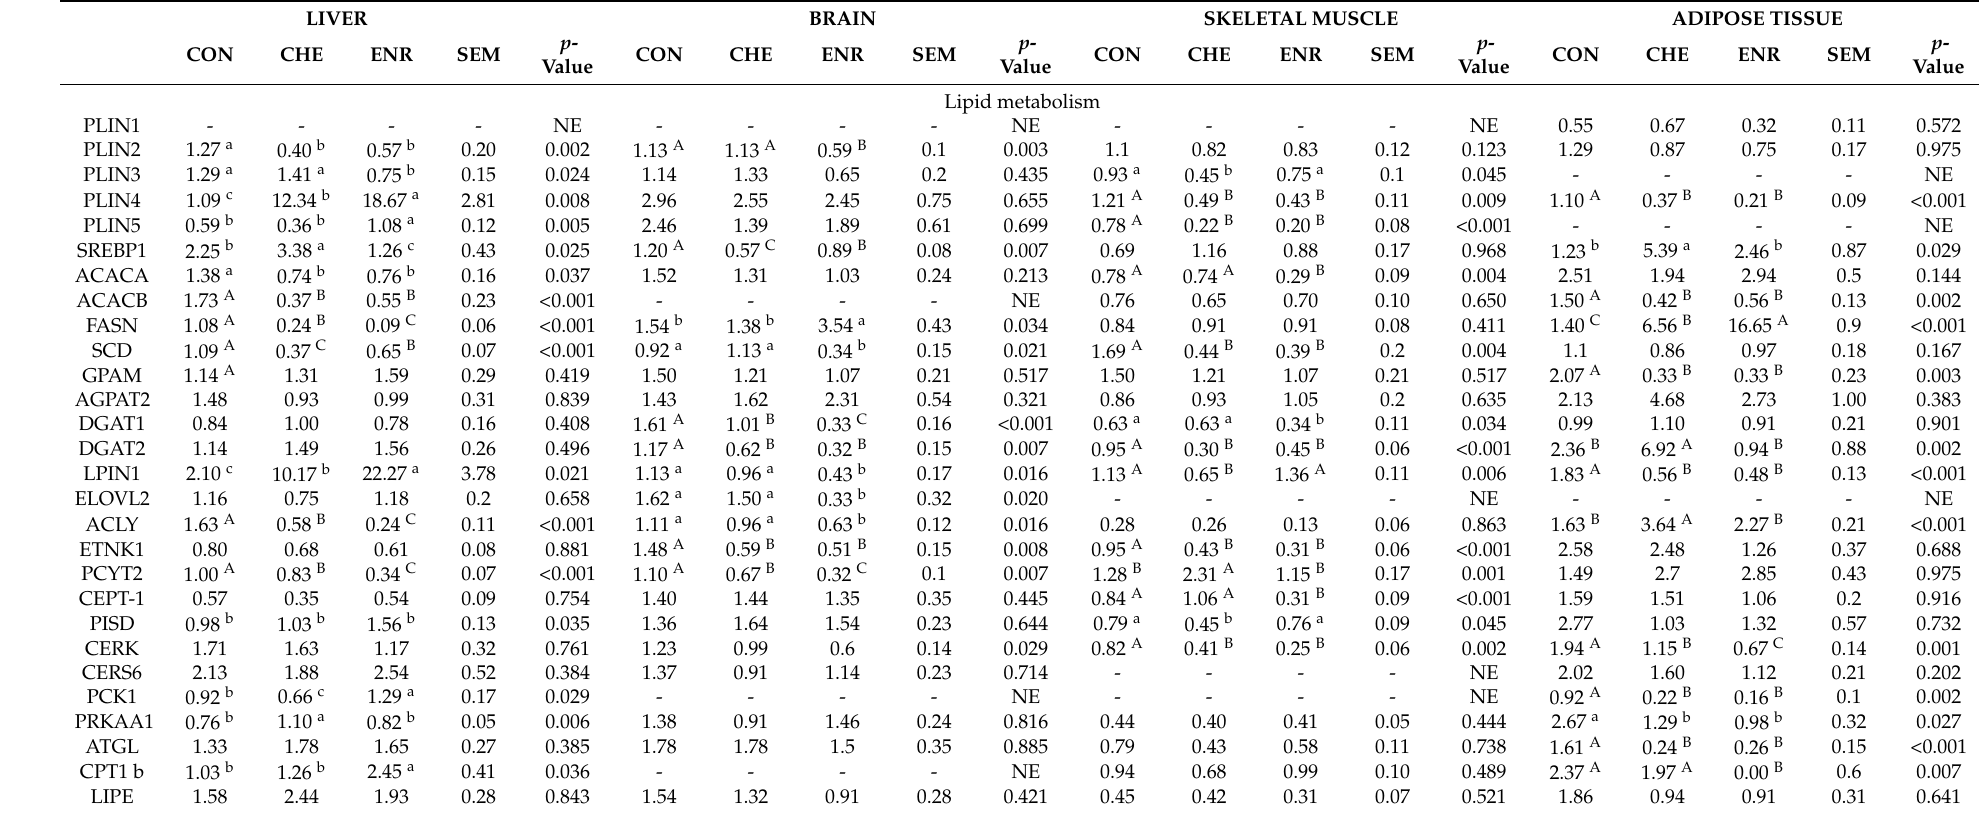
Table 7. Effect of the diet on the gene expression of liver, brain, skeletal muscle and adipose